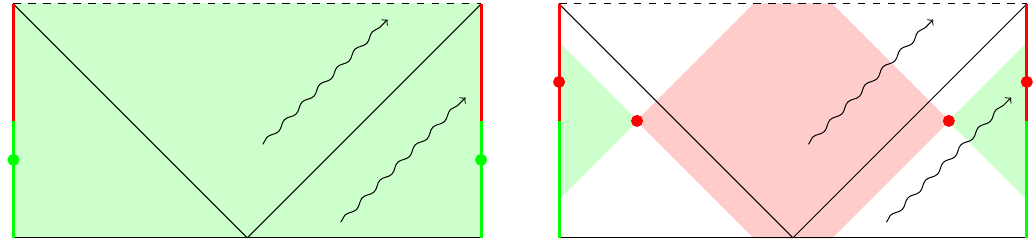
Figure 4 . The time evolution of the entanglement structure. For early boundary times (left), the entanglement wedge of the green boundary points consists of the entire AdS region. For late times, past the Page time, (right) the minimal entropy is captured by a con(cid:12)guration with 2 QES’s outside the horizons. The entanglement wedges of the red boundary points are now much smaller and an island forms between the QES’s (the pink region). Also shown is a Hawking mode and its partner behind the horizon. Before the Page time, the both modes are in the entanglement wedge of the boundary point whereas after the Page time the partner mode is now in the